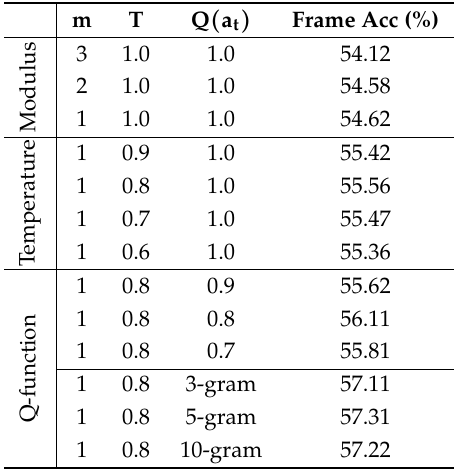
Table 3. The proposed method performance.